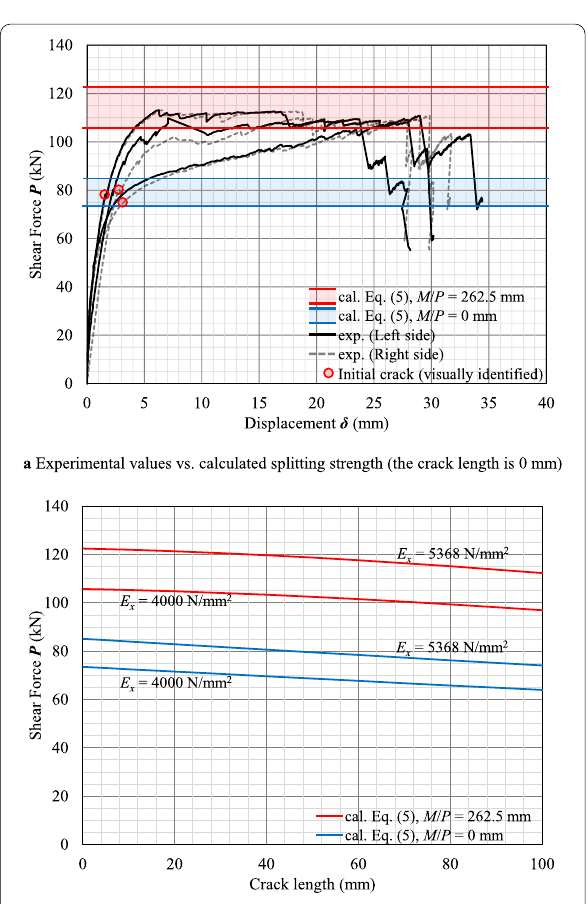
Fig. 27 Calculated value of the splitting strength for J-L150